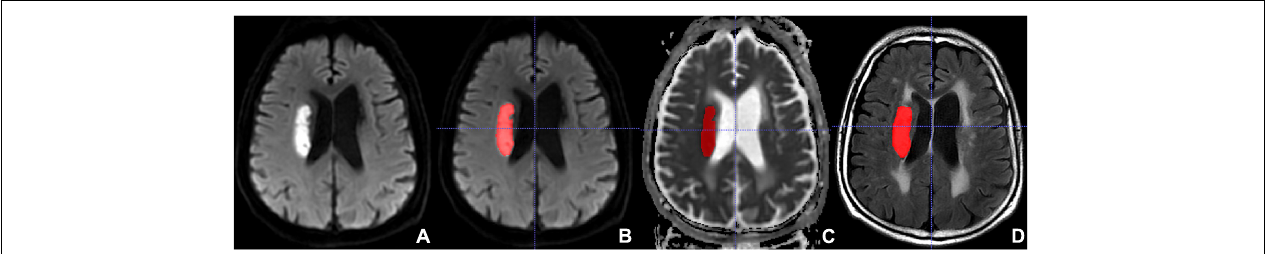
FIGURE 2 | Lesion segmentation with the Insight Segmentation and Registration Toolkit-ANAP (ITK-SNAP). (A) Non-segmented diffusion-weighted imaging (DWI). (B) Segmented DWI. (C) Segmented apparent diffusion coefficient (ADC). (D) Segmented fluid-attenuated inversion recovery (FLAIR).